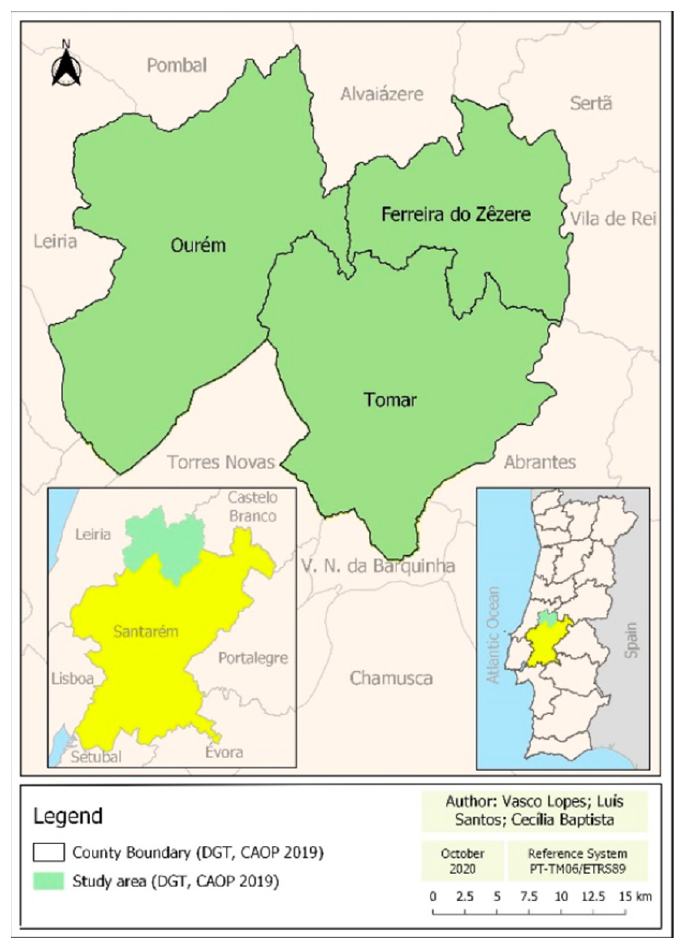
Figure 1. The geographical location of the study region.